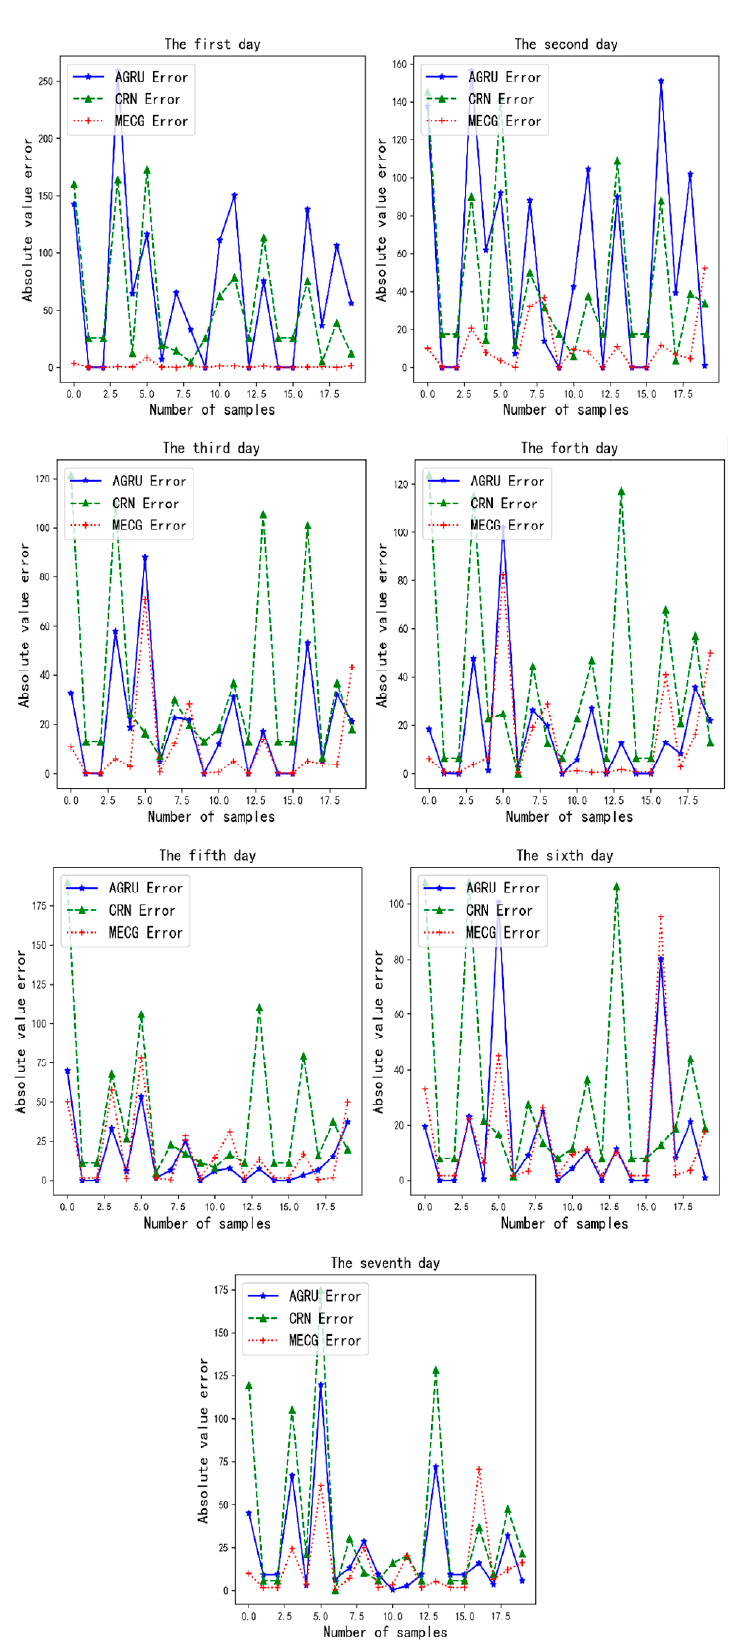
Figure 9. Absolute value error chart of 20 samples randomly selected.